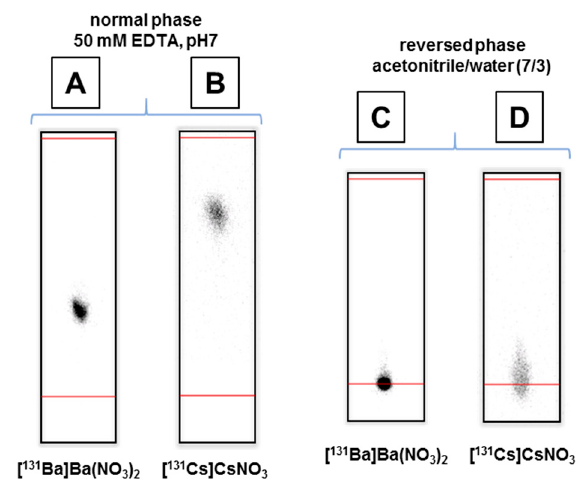
Figure 5. Radio-TLCs of [ 131 Ba]Ba 2 + and [ 131 Cs]Cs + using normal phase TLC plates ( A , B ) and reverse phase TLC plates ( C , D ).